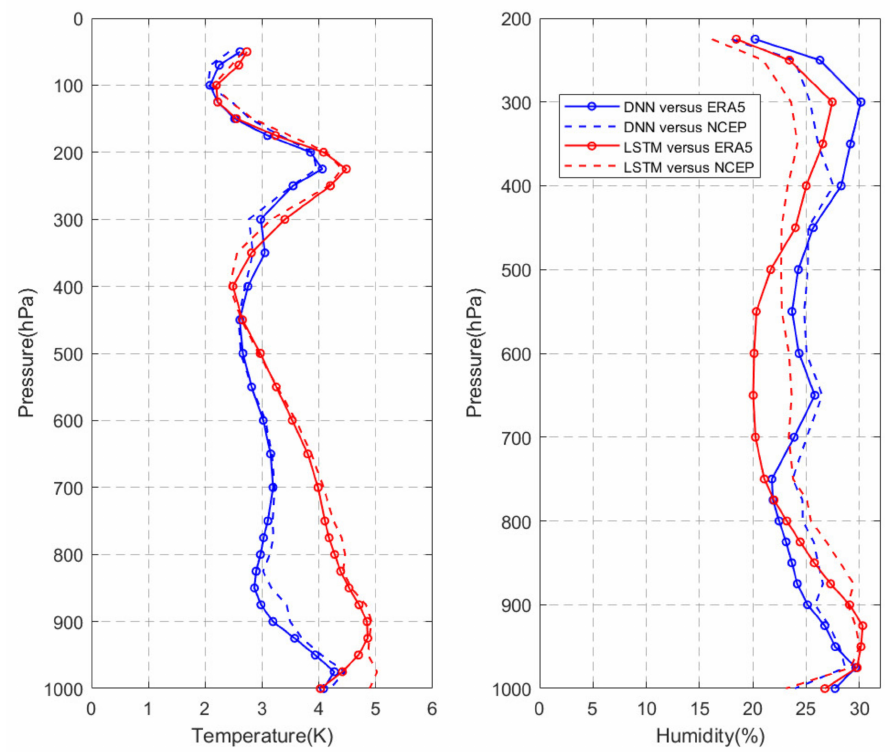
Figure 12. The retrieval RMSEs of the DNN model and the LSTM model with respect to ERA5 and NCEP reanalysis data over mixed ice–water in February